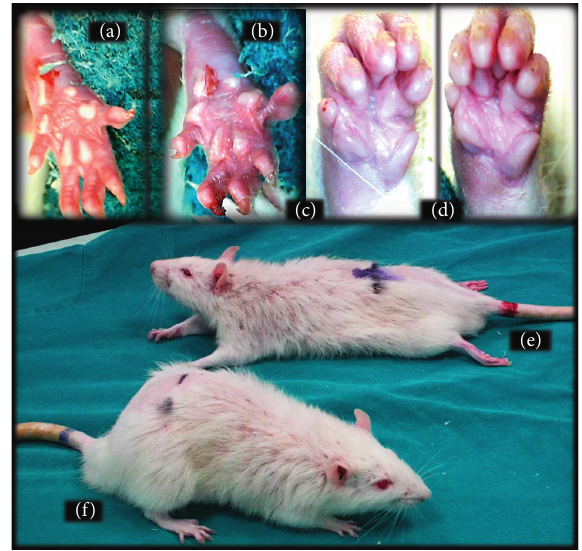
Figure 11: Illustrative presentation of the effects of the lidocaine-induced local anesthesia (intraplantar application (b) and axillar (d) and spinal (e) block) and corresponding BPC 157 counteraction ((a), (c), and (f)). Hind limb, plantar, and digits oedema in control rats (b) and counteraction in BPC 157 rats (a) immediately after 120sec hot plate test. Fore limb, palmar, and fingers oedema in control rats (d) and counteraction in BPC 157 rats (c) presented at 30min following lidocaine-induced axillary block. Presentation of the intrathecal anesthesia effect: prolonged hind limbs function failure and long-lasting flaccid paralysis (e) and recovery in BPC 157 rats (f) at 50min following